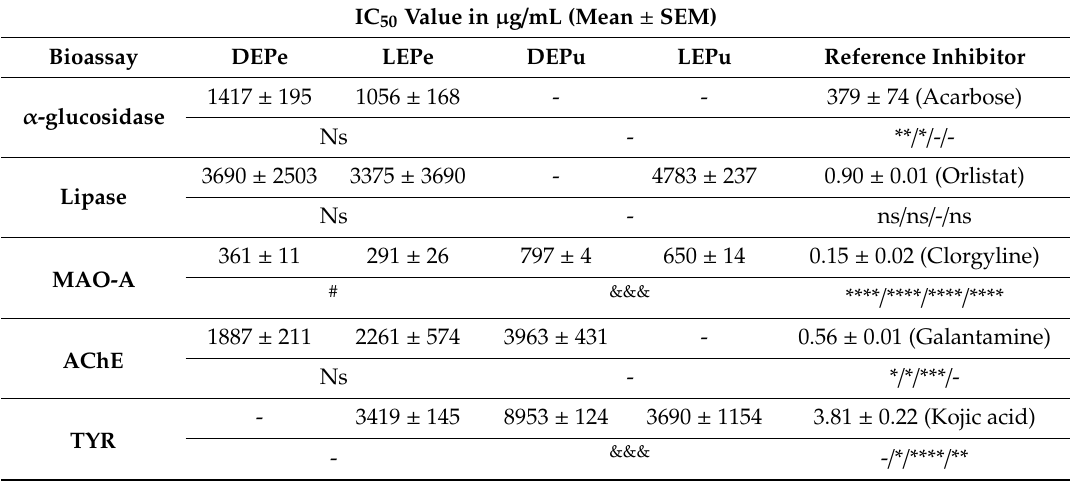
Table 3. IC 50 values ( µ g / mL) of di ff erent extracts in di ff erent tested